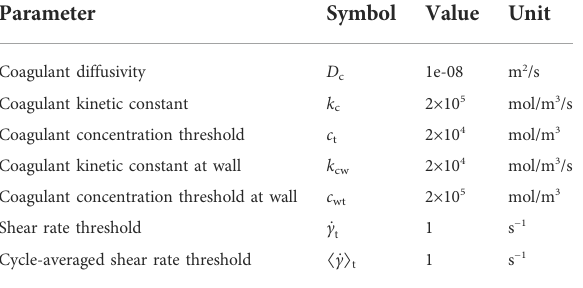
TABLE 1 Thrombus formation model